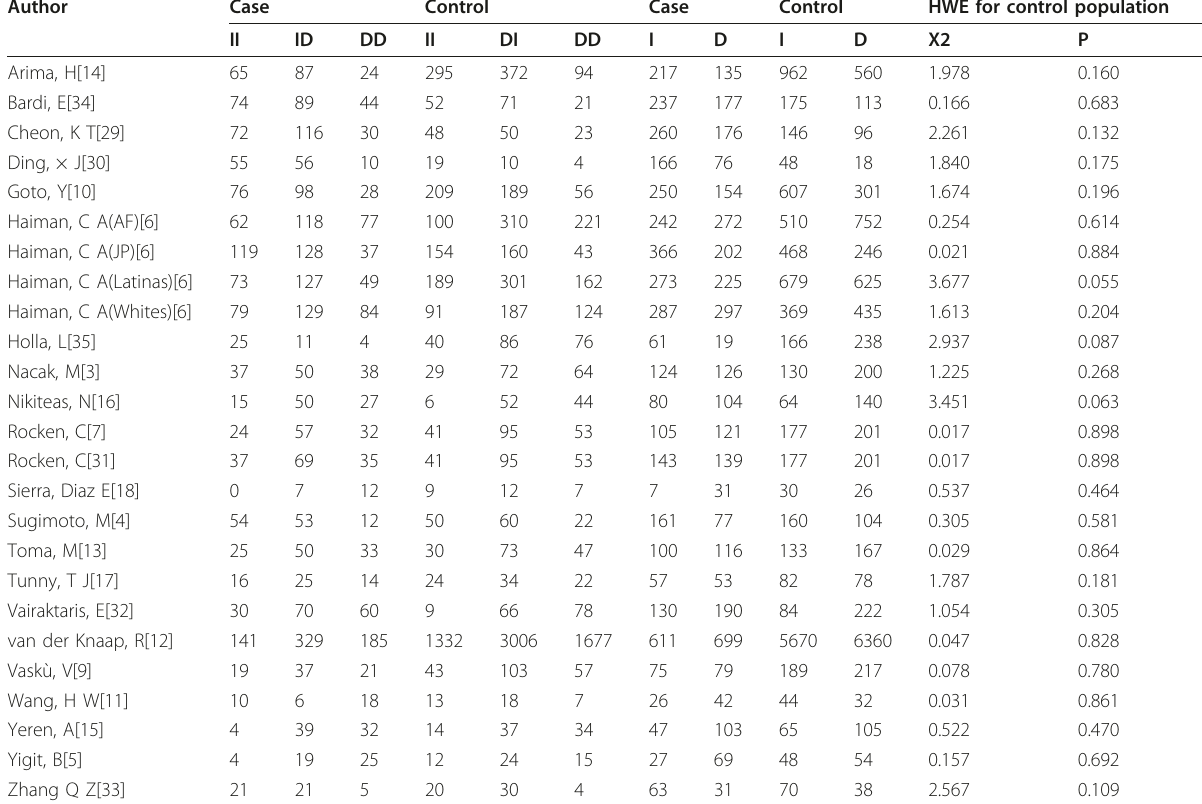
Table 2 Distribution of ACE genotype and allele among asthma patients and controls